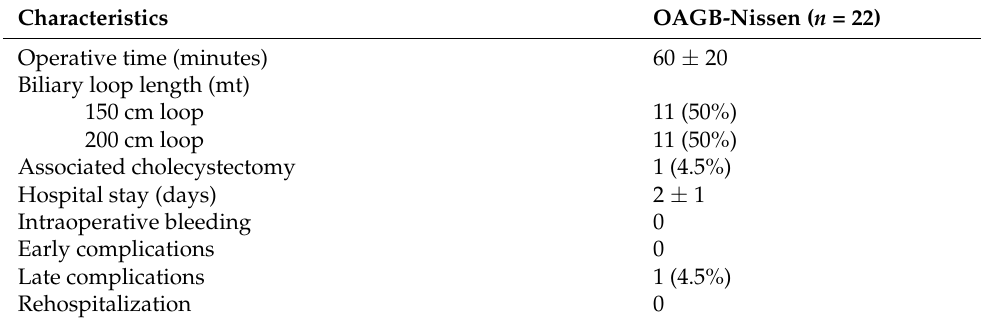
Table 2. Intraoperative and postoperative